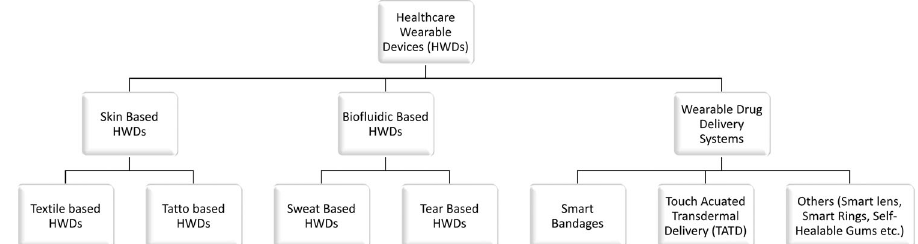
Fig. 1 Classi fi cation of Healthcare Wearable Devices (HWDs). Organization of the paper showing the classi fi cation of HWDs including Skin based HWDs, Bio fl uidic based HWDs, and Wearable Drug Delivery Systems along with their